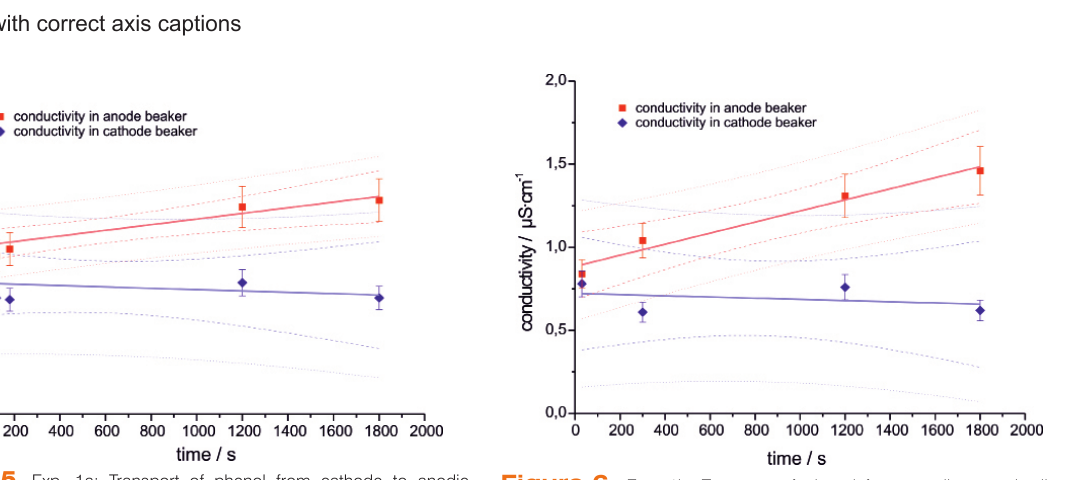
Figure 6. Exp. 1b: Transport of phenol from anodic to cathodic beaker, conductivity measurement evaluated with a linear fit including 95% confidence (dashed) and 95% prediction (dotted)